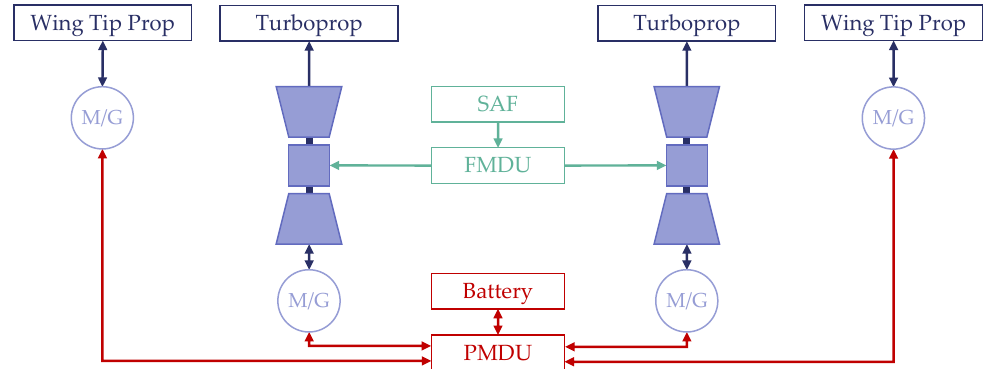
Figure 2. Scheme drawing of the parallel hybrid-electric Architecture